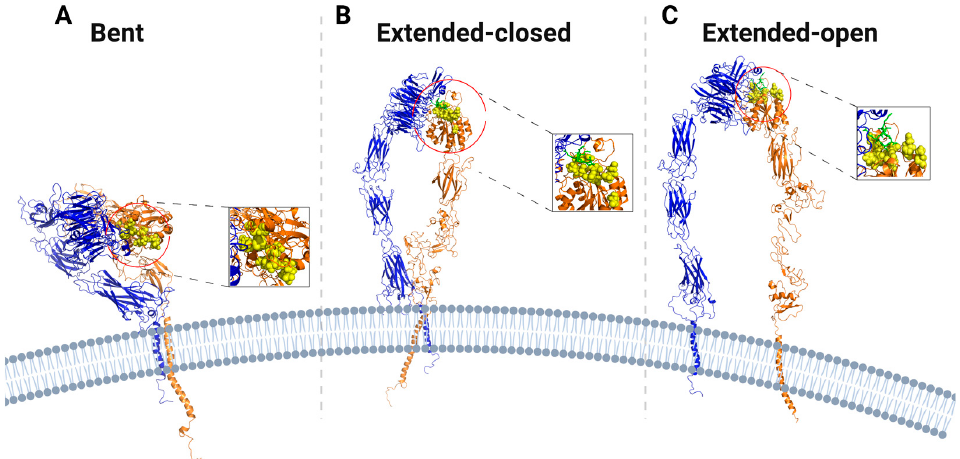
Figure 2. Reorientation of the ligand-binding interface during conformational activation of integrin α IIb β 3. ( A ). Ribbon representation of the platelet α IIb β 3 integrin in the bent conformation, with the ligand-binding interface (yellow, vdW representation) oriented towards the lower legs. ( B , C ). Ribbon representation of integrin in intermediate and extended-open conformations, with the ligand-binding interface (yellow, vdW representation) oriented away from the lower legs. The α subunit and the β subunit are represented in blue and orange, respectively. All structures are acquired from cryo-EM reconstructions of α IIb β 3 integrin [24].